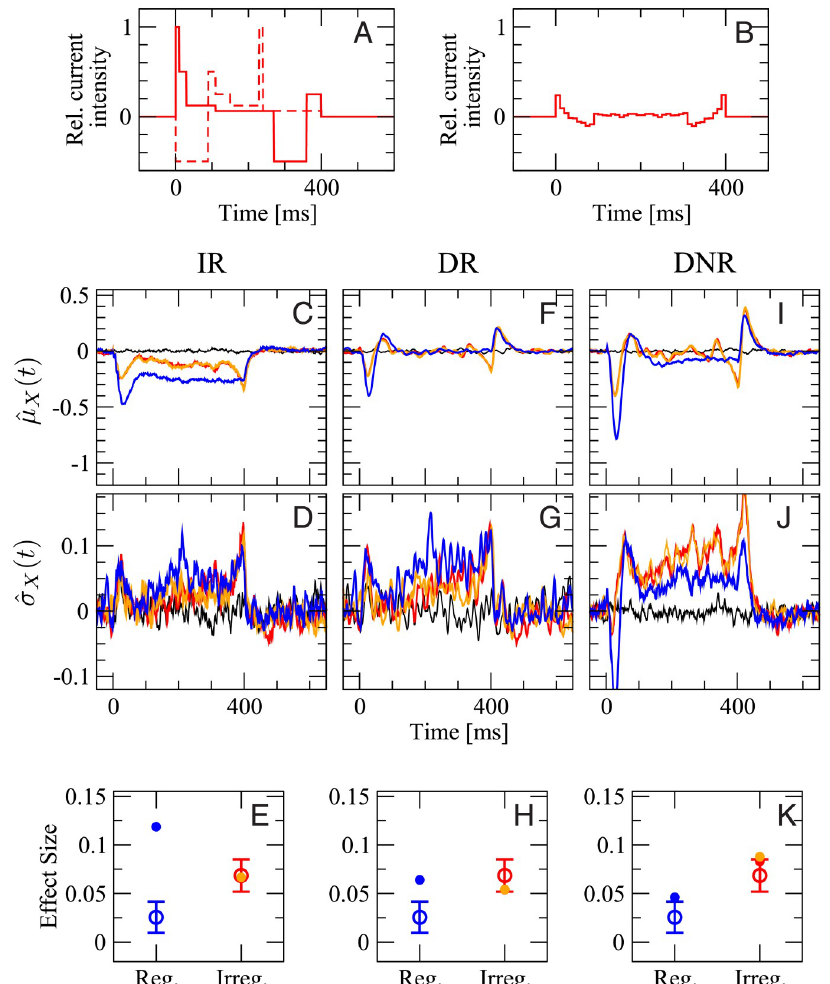
Fig 9. In the comparison irregular vs. regular stimulation, simulation results from DNR agree well with the experimental data, whereas results from the IR are most inconsistent with the data. Blue lines and symbols refer to the 400 ms regular stimulus, as in the previous cases; Red and orange lines and symbols refer to two different random samples of 10000 irregular stimuli (two specific realizations are shown in A , the average stimulus is shown in B ; for details see text). Black line is catch trial condition (no stimulus). First row ( C,F,I ): deviation from the spontaneous value of the time-dependent mean readout activity normalized by the spontaneous standard deviation, defined in Eq (13). Second row ( D,G,J ): deviation from the spontaneous value of the time-dependent standard deviation of the readout activity normalized by the spontaneous standard deviation, defined in Eq (16). Third row ( E,H,K ): average effect size. Open circles with error bars: experimental data (average over 62 RS cells and 1780 total trials); filled circles of corresponding color: model simulations. First column ( C,D,E ): IR. Second column ( F,G,H ): DR. Third column ( I,J, K ):